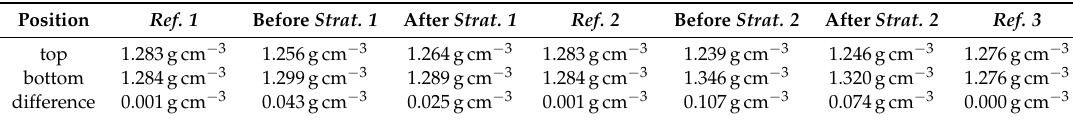
Table 2. Measured acid densities in the top and bottom of the test cell at different states of measurement